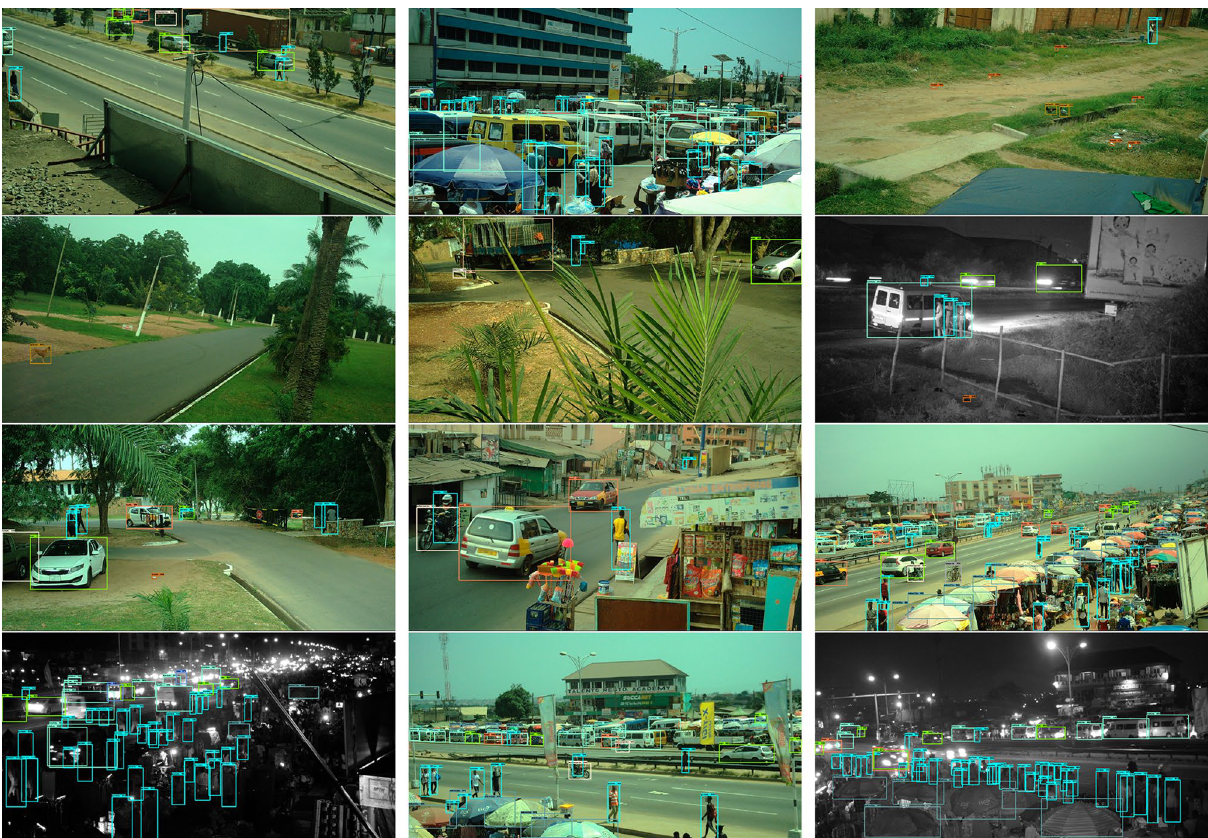
Figure 2. Objects identified in example images. Each identified object is bounded by a box, coloured by object type. The number next to the object’s name shows the final layer’s activation score for the given object’s classifier, which may be heuristically interpreted as the network’s confidence score in its prediction. “Truck” refers to pick-up truck, “Bowl” refers to cooking bowl/pot, “Stall” refers to market stalls and “Stove” to cookstoves of the type found in